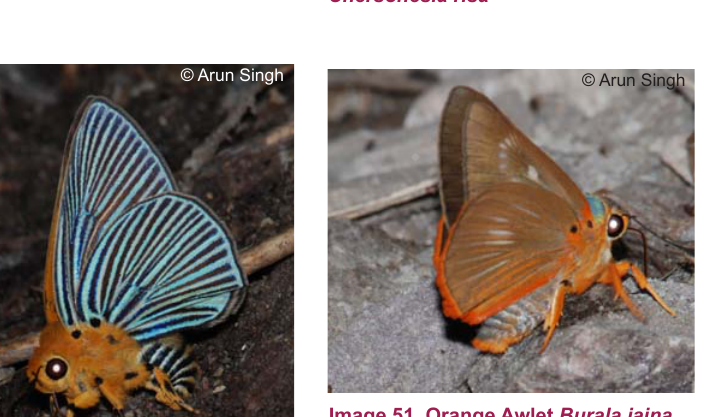
Image 49. Black Prince Rohana parisatis (male)